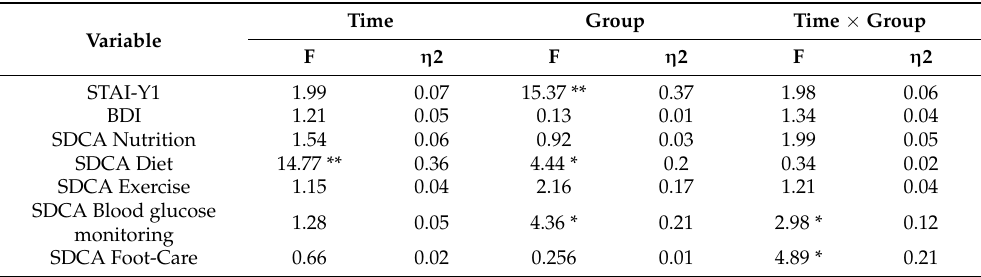
Table 1. Results of the two-way mixed-design ANOVA—within/between participant’s effects and their